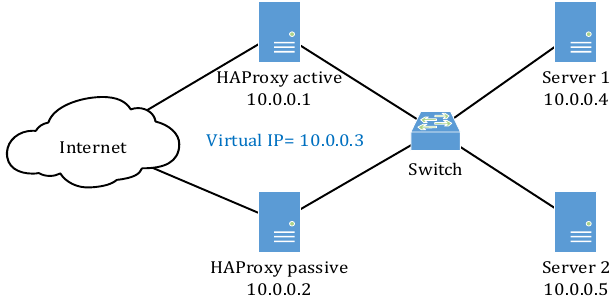
Figure 1. HAProxy with Keepalived (drawn from text [18]) The SLB router is an IOS image of Cisco router. Inside SLB router, a virtual server is defined to represent a list of real servers called server farm. SLB router redirects messages from clients to this virtual server, and then the virtual server redirects messages to one of the servers in the server farm. According to a specified LB technique [21], SLB can be in one of the two modes: Directed mode indicates that virtual server can be configured with any class of IP regardless of the class of the servers in the server